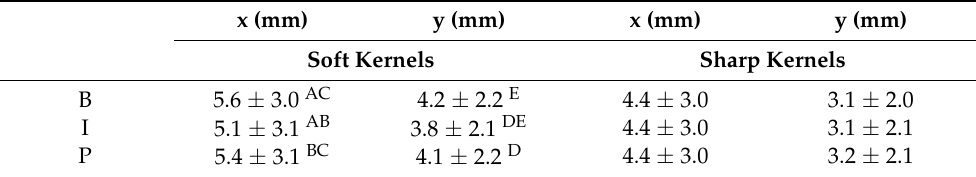
Table 1. Results of the stone size measurements and statistical analysis. Size measurements of the three evaluated reconstructions were compared (B vs. I, I vs. P, P vs. B). Differences between meas- urements with shared superscripts were statistically significant. There were no significant differ- ences between sharp kernel reconstructions.